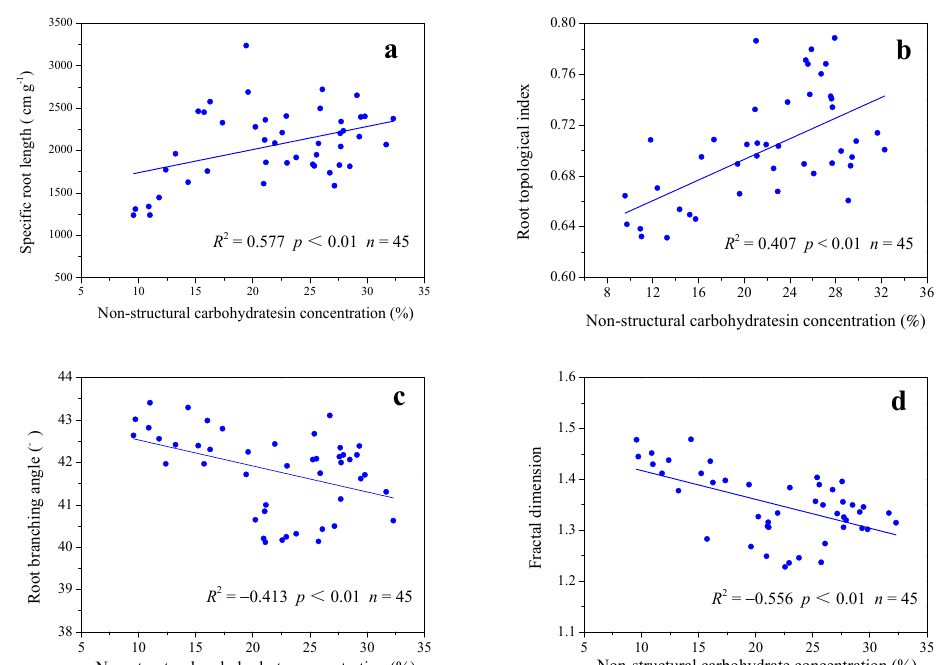
Figure 7. Relationships between non-structural carbohydrate concentration and root architecture parameters (root topo- logical index ( b ), root branching angle ( c ), and fractal dimension ( d )) as well as specific root length ( a ) during the whole experiment period. R: correlation coefficient; n : total number of samples.